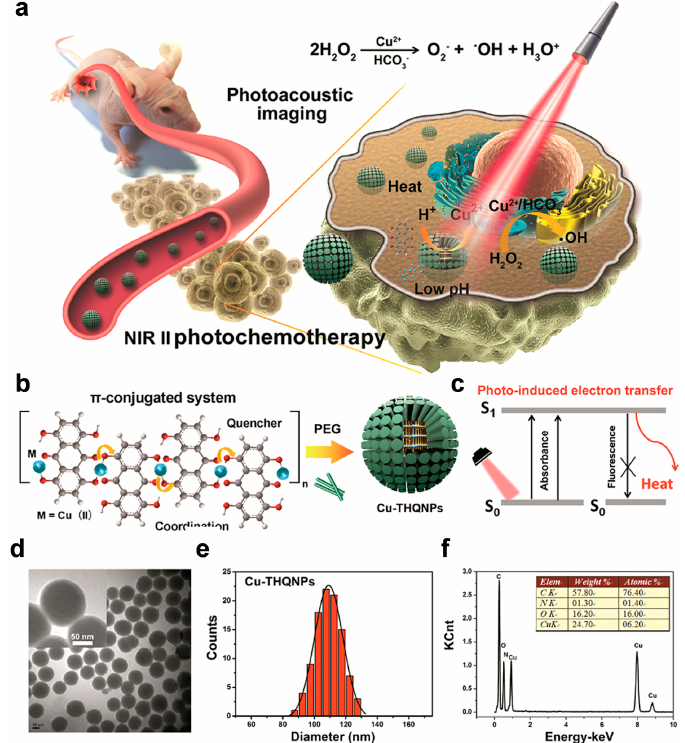
Figure 21. ( a ) Schematic illustration of the behavior of Cu(II) − THQNPs upon 1064-nm laser irradiation in vivo. ( b ) Synthesis of Cu(II) − THQNPs by a one-step method. ( c ) Mechanism of Cu(II) −